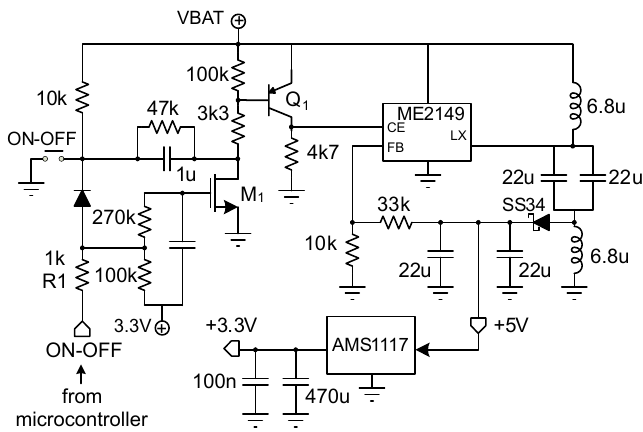
Figure 4. Power Supply System